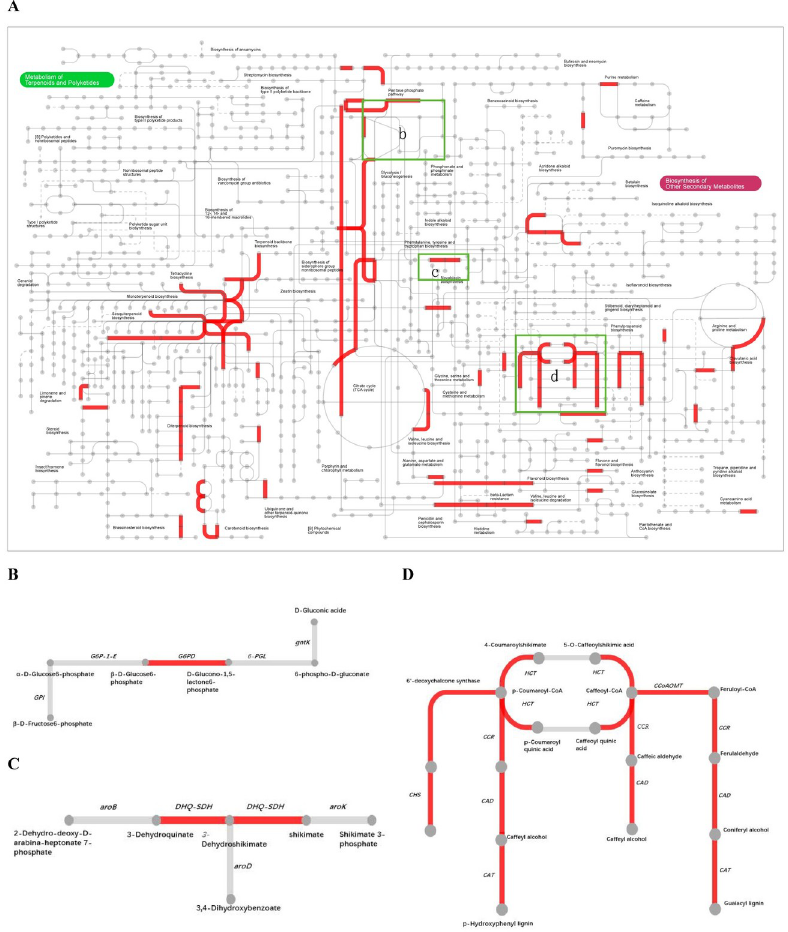
Fig 5. Interactive pathways analyses during CGA accumulation. (A) The red lines indicated genes with significant expression change. (B) Pentose phosphate metabolism. (C) Phenylalanine biosynthesis. (D) CGA biosynthesis.